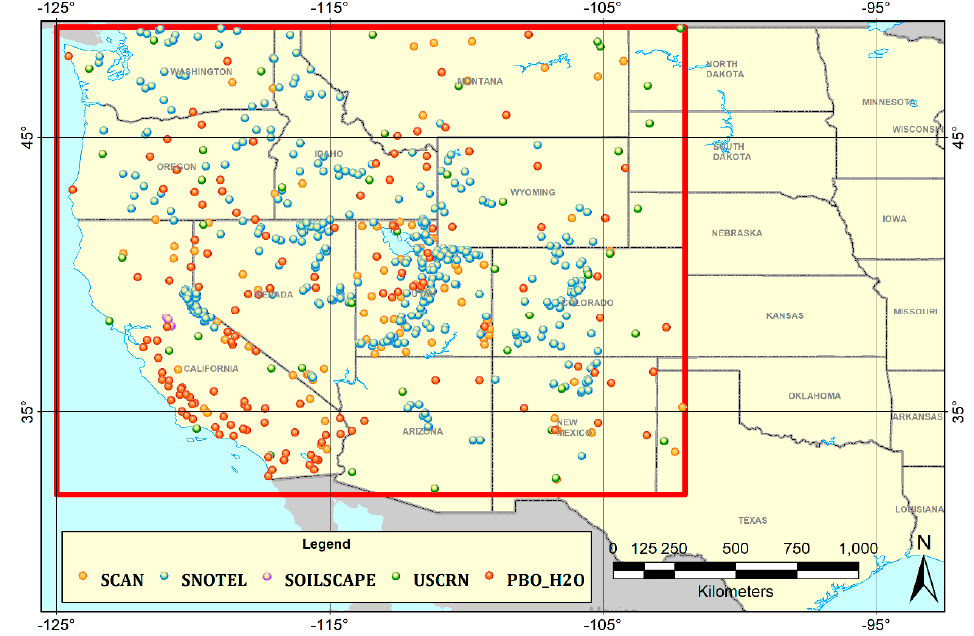
Figure 1. Study area (red rectangle, 32°N–49°N, 125°W–102°W) and distribution of the soil moisture networks including four in-situ networks (the Soil Climate Analysis Network (SCAN) network, the SNOwpack TELemetry (SNOTEL) network, the Soil moisture Sensing Controller and oPtimal Estimator (SoilSCAPE) network, and the U.S. Climate Reference Network (USCRN) network) and one Global Navigation Satellite System interferometric Reflectometry (GNSS-R) network (the PBO H2O network).